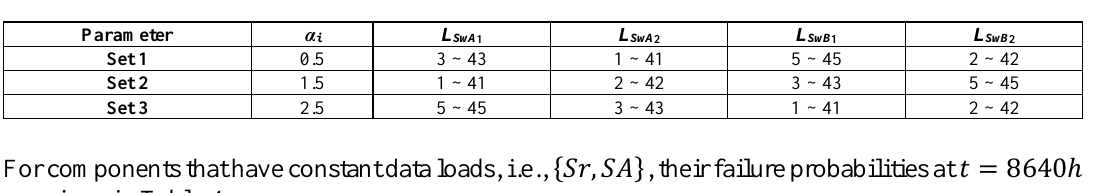
Table 7 summarizes the load-dependent failure rate of each switch i , 𝑖 ∈ {𝑆𝑤𝐴1, 𝑆𝑤𝐴2, 𝑆𝑤𝐵1, 𝑆𝑤𝐵2} , ( λ evaluated using Eq. (2)) and the entire SAN reliability ( R i